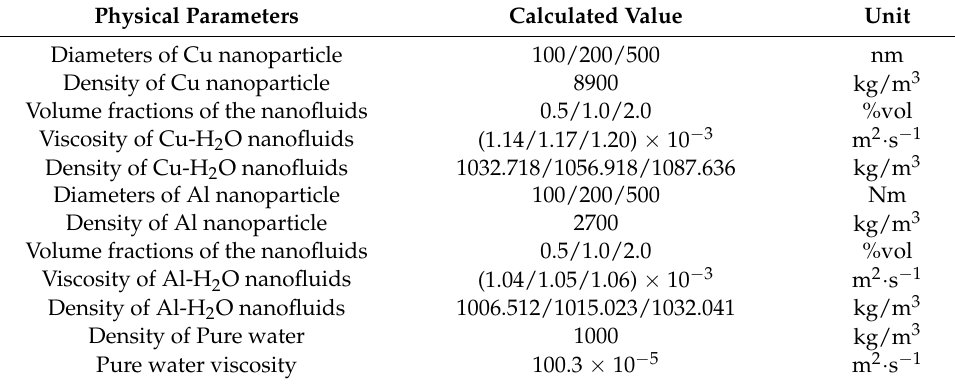
Table 1. Material property parameters